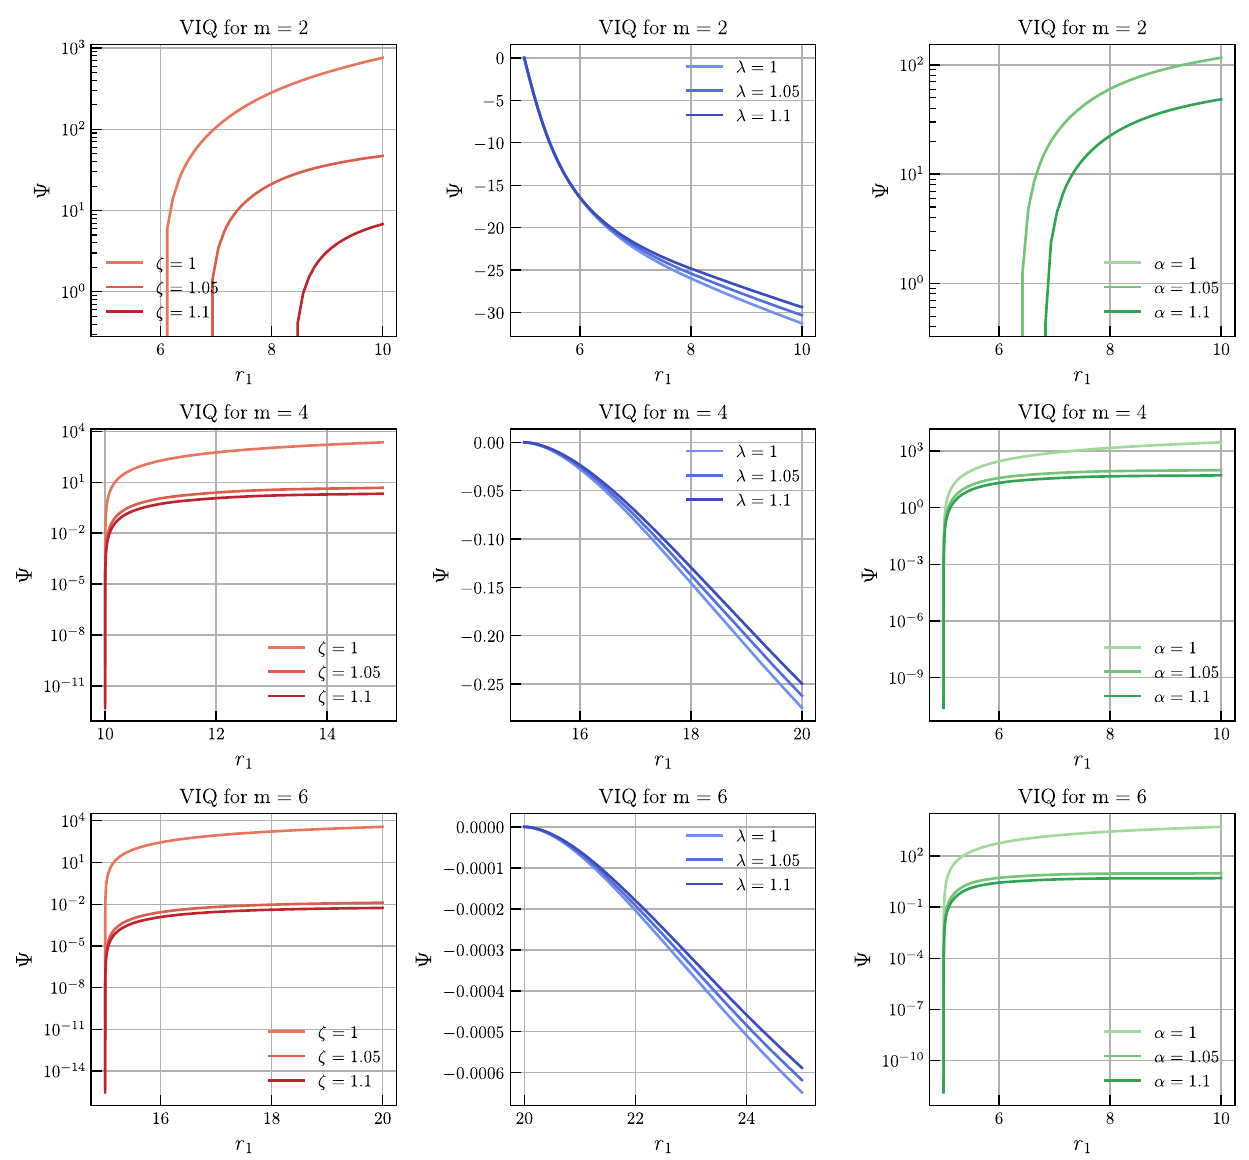
Fig. 7 Volume integral quantifier for the exponential ( first column ), Hu–Sawicki ( second column ) and Gamma ( third column ) gravities. Free MOG parameters take values that were assumed for energy conditions previously